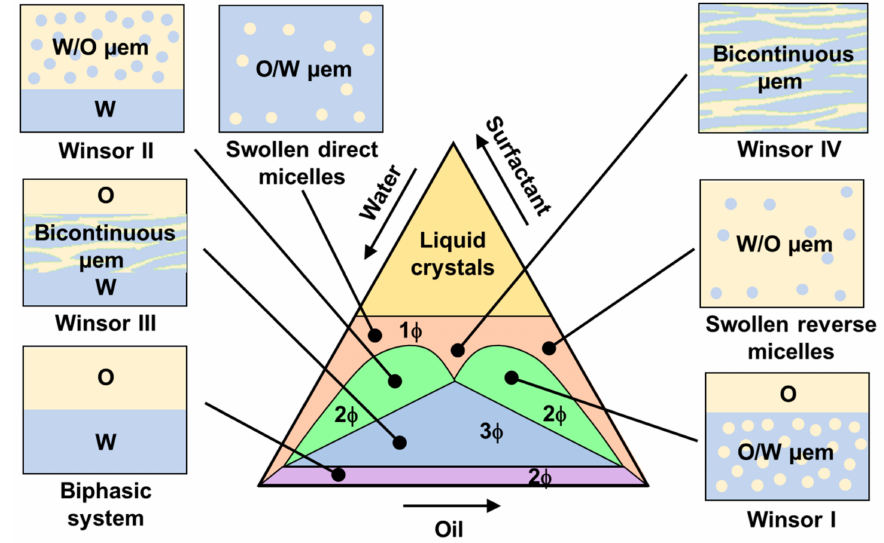
Figure 29. A schematic phase diagram of a surfactant/water/oil ternary system and microemulsion Winsor types. Note that the boundaries are arbitrary and depend on the system